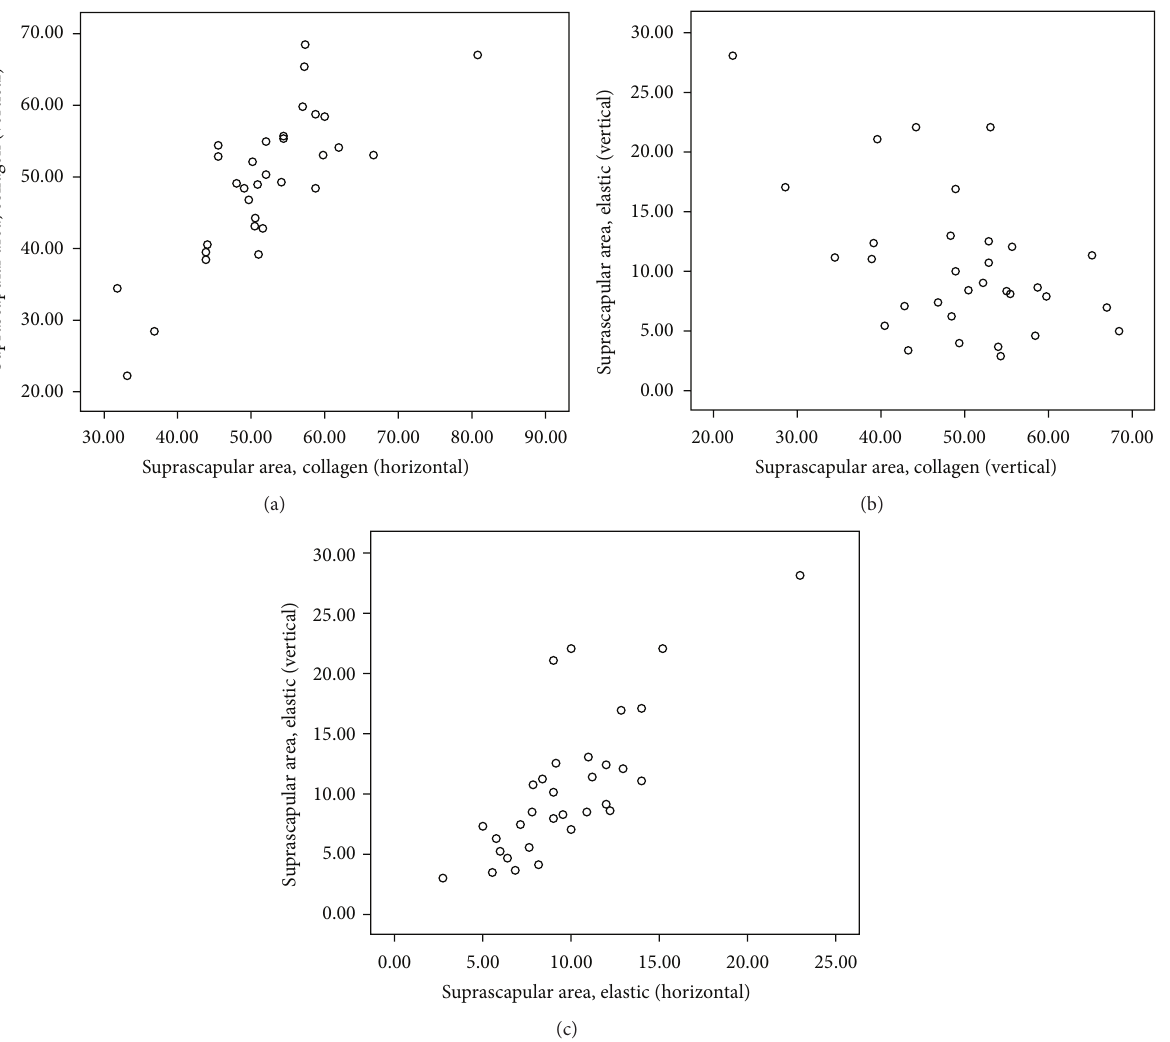
Figure 1: Scatter plot of significant Spearman correlation pattern at suprascapular area. (a) Strong positive correlation between C H and C V , (b) low negative correlation between C V and E V , and (c) strong positive correlation between E H and E V (C H : collagen in horizontal, C V : collagen in vertical, E H : elastic in horizontal, and E V : elastic in vertical direction). Table 2: Spearman’s correlation coefficient ( 𝑟 ) and its level of significance ( 𝑝 ). Variables